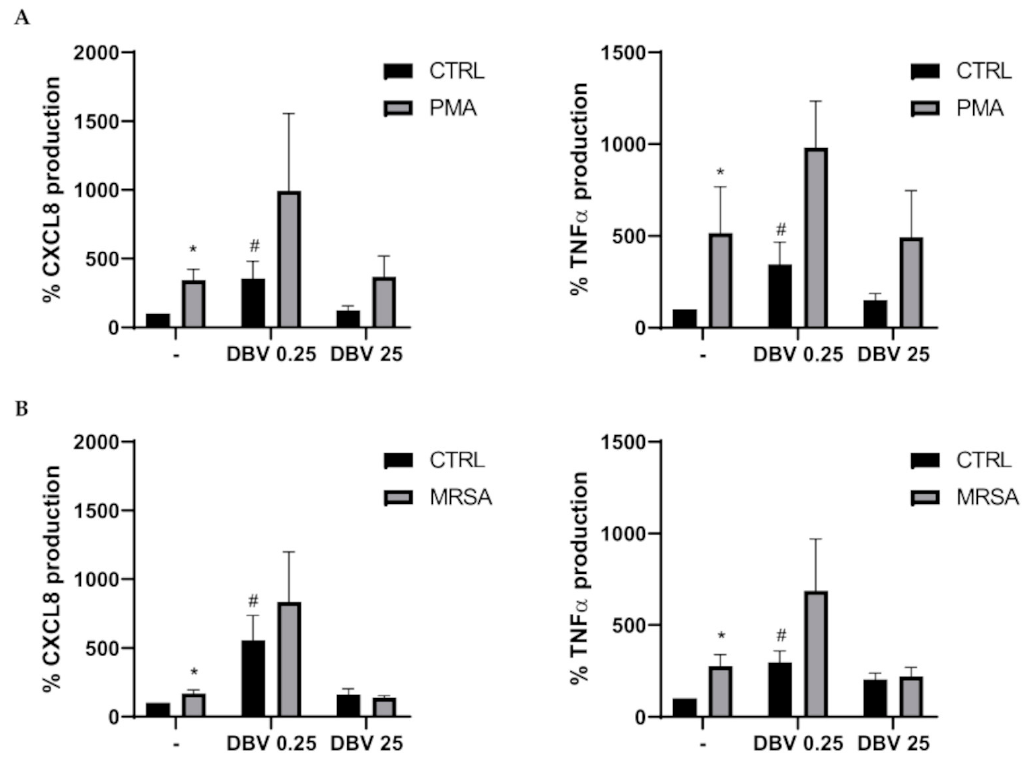
Figure 5. Effect of DBV on cytokine release by PMNs. PMNs were treated with DBV (0.25 and 25 µ g/mL) and then activated with PMA (100 nM) ( A ) or MRSA (10:1) ( B ) for 4 h. The production of CXCL8 and TNF α in cell supernatants is shown with results expressed as percentage of release with respect to untreated cells (CTRL) considered as 100%. Values are means ± SEM of at least three independent experiments. * p < 0.05 vs. CTRL; # p < 0.05 vs.